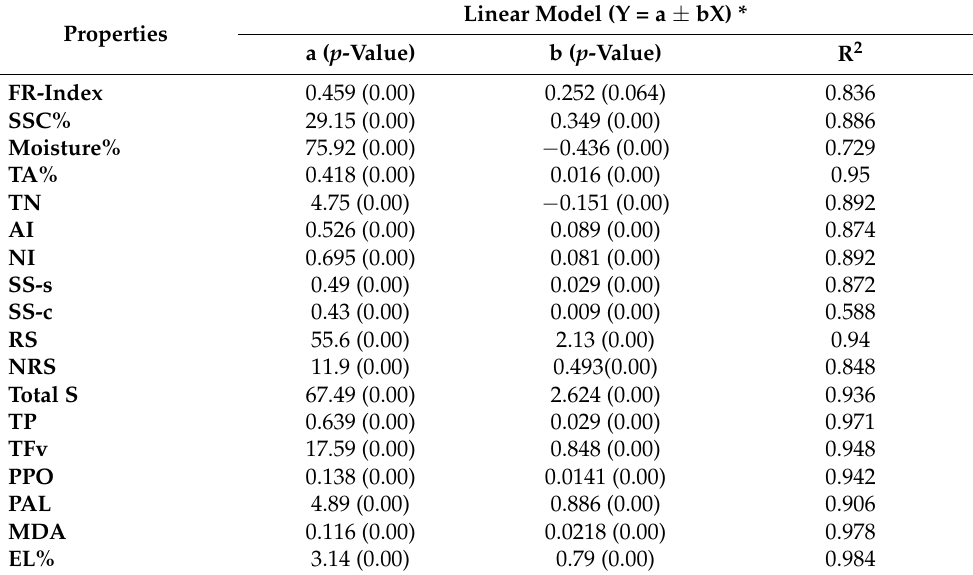
Table 2. Modelling of changes in the properties during shelf-life of the treated dates with ATP 1.5 mM.